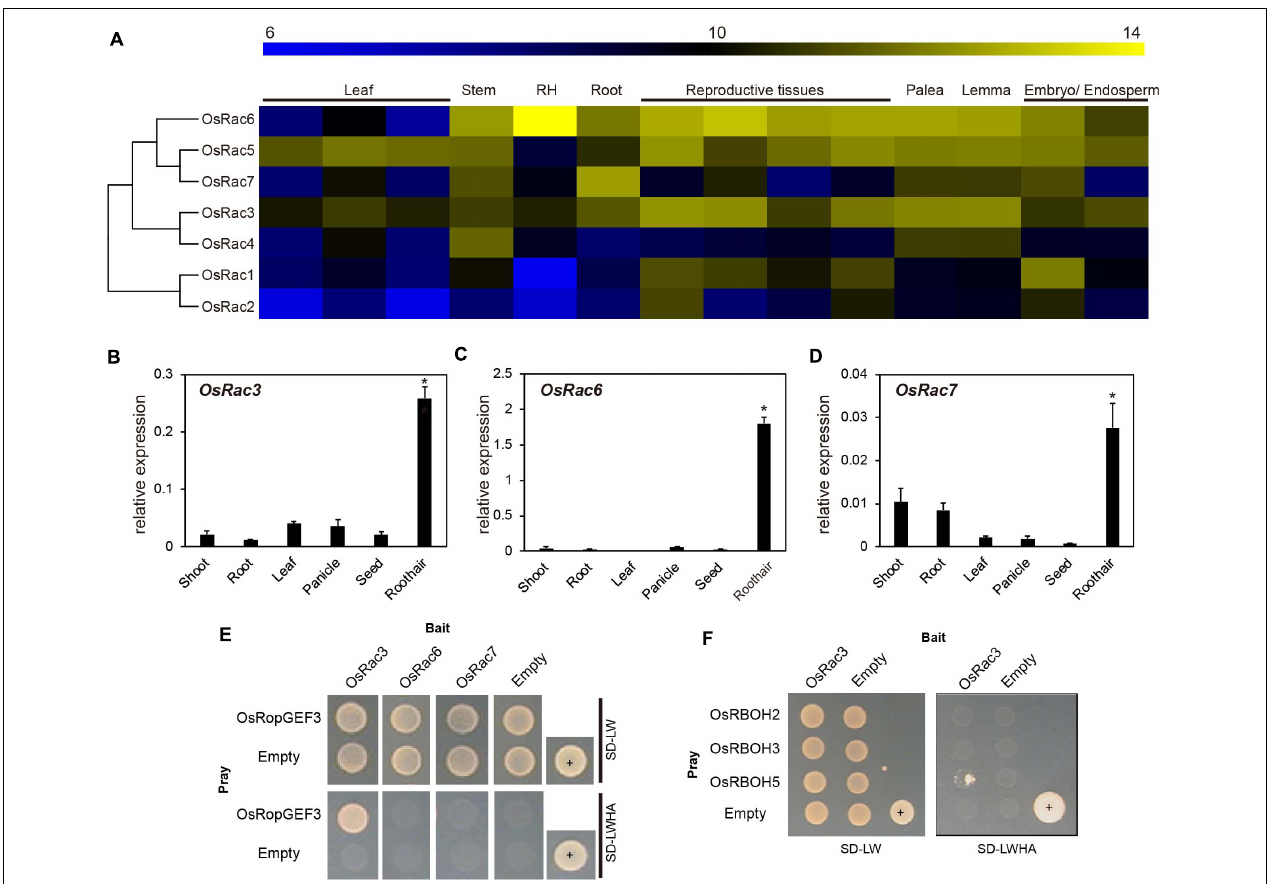
FIGURE 5 | Expression pattern of OsRac and identification of the interacting proteins using yeast two-hybrid analysis. (A) Microarray meta-expression analysis and phylogenetic tree of seven OsRac genes. The phylogenetic tree was constructed by neighbor-joining methods. In the heatmap, the yellow color indicates a high expression, and the blue color indicates a low expression. Numeric values indicate an average of the normalized log2 intensity of microarray data. Leaf includes the leaf blade, leaf sheath, flag leaf, and reproductive tissues including the anther, carpel, ovary, and pistil. RH, root hair. (B–D) Expression verification of OsRac using real-time quantitative PCR (RT-qPCR). Rice ubiquitin 5 (LOC_Os01g22490) was used as an internal control. X -axis, the sample name used for analysis; Y -axis, the relative expression level of the OsRac3 , OsRac6 , and OsRac7 . The error bar indicates standard errors in three biological replicates. Significant differences are indicated by asterisks, * p < 0.01. The data were analyzed using one-way ANOVA with repeated measurements using Tukey’s pairwise comparison test. (E) The interaction between OsRopGEF3 and three OsRac (OsRac3, OsRac6, and OsRac7) evaluated using the yeast two-hybrid system. (F) Identification of the interaction between OsRac3 and three OsRBOH that have highly specific expression in root hair tissues. SD-LW, synthetic defined media without Leu and Trp; SD-LWHA, synthetic defined media without Leu, Trp, His, Ala; + , positive control; empty vector of pGADT7 and pGBKT7 used as a negative control.